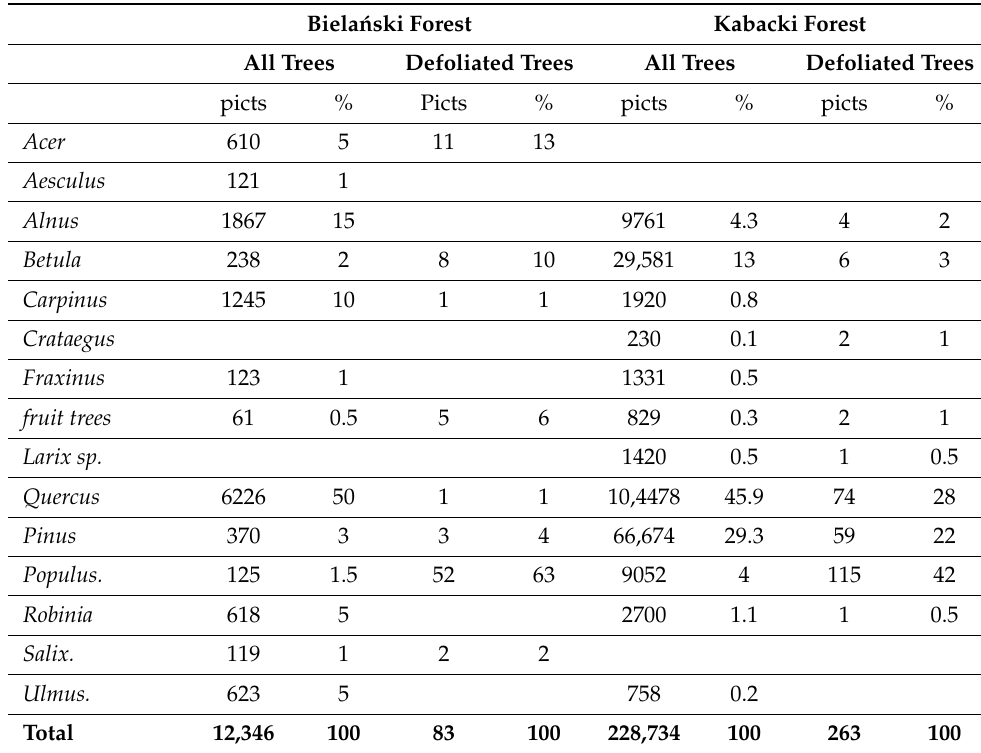
Table 1. List of all trees and defoliated trees in the Biela´nski Forest and the Kabacki Forest. Biela´nski Forest